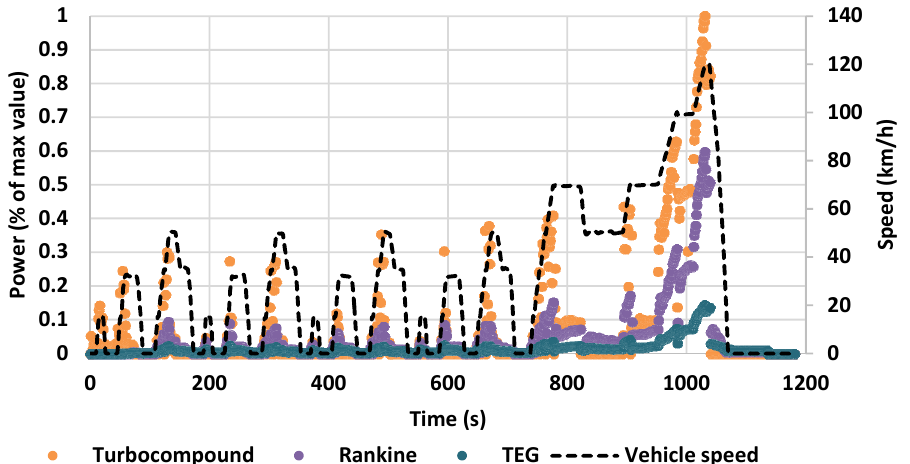
Figure 10. Evolution of the normalized produced power of a turbocharged engine in function of the time with the speed profile of the driving